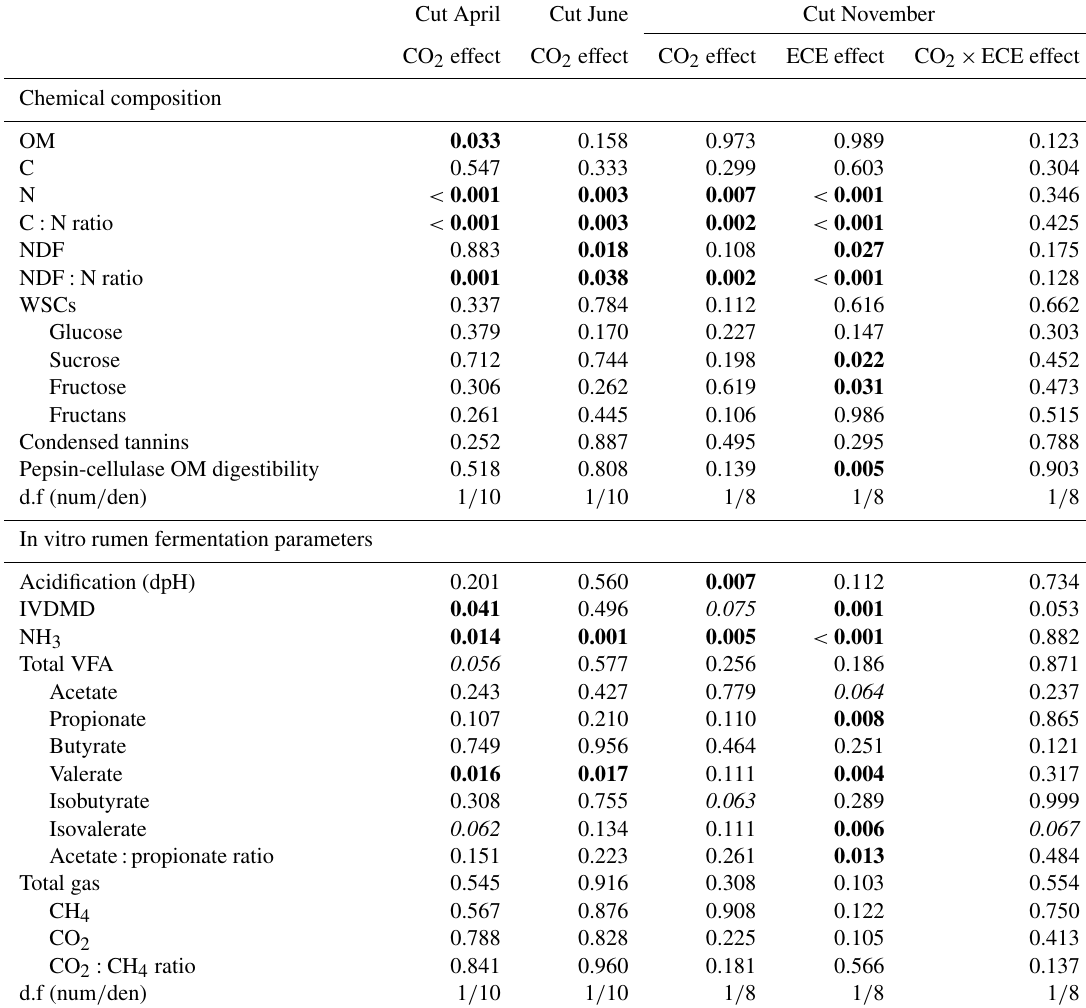
Table 4. Factor effects ( p values) on chemical composition and in vitro rumen fermentation parameters of plant communities exposed to two levels of CO 2 concentration (390 and 520ppm) with or without an extreme climatic event (ECE) at three different cutting